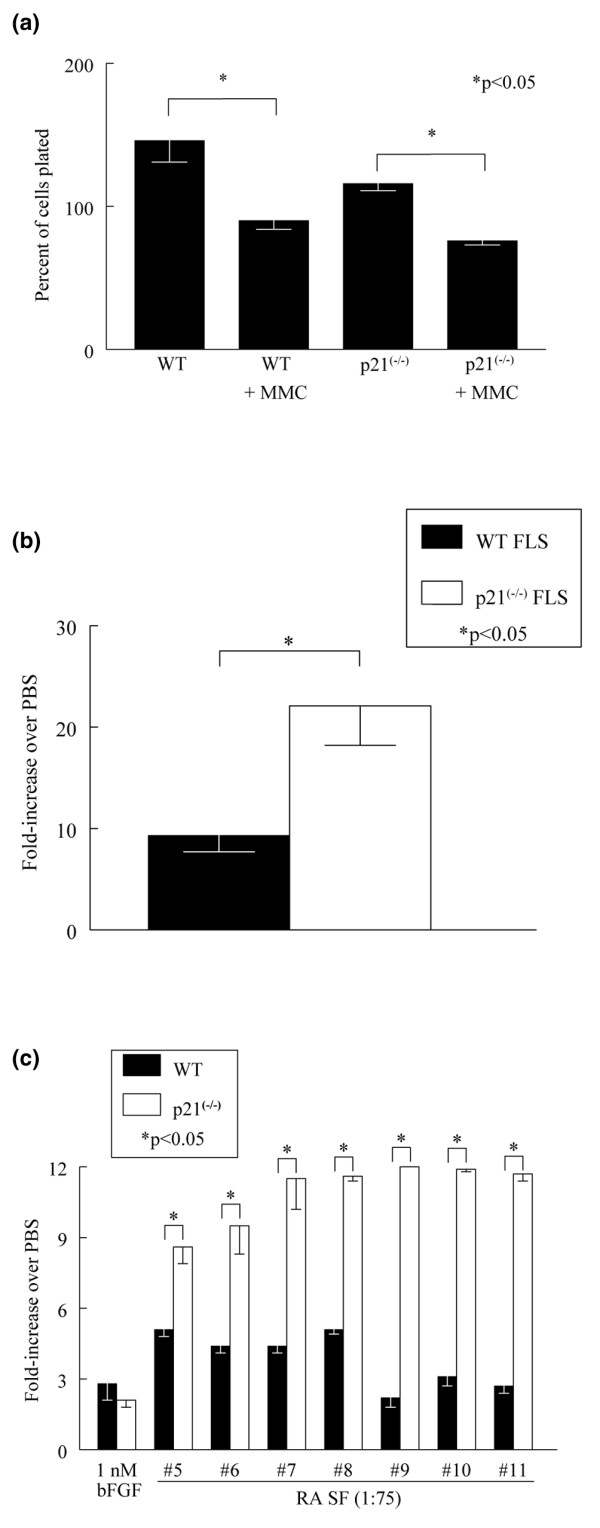
Enhanced migration of p21(-/-) fibroblast-like synoviocytes (FLS) to rheumatoid arthritis (RA) synovial fluid (SF) is independent of cell cycle regulation. (a) Wild-type (WT) and p21(-/-) FLS were treated identically to the chemotaxis assay in the presence and absence of mitomycin C (MMC) to determine whether the MMC conditions applied allowed for any proliferation of FLS. Cell counts are expressed as the percentage of cells plated, which was determined by counting the number of cells present after 2 h. The asterisk indicates a statistically significant difference between the groups, as determined from three identical experiments. (b) WT and p21(-/-) FLS were allowed to adhere to the bottom side of the membrane with the chamber inverted in the presence of 10 μg/ml MMC. Subsequently, cells were introduced to gradients of RA SFs diluted 1:75 to induce migration. Cell counts are expressed as fold-increase over background migration to PBS (negative control). An asterisk indicates a statistically significant difference. Combined chemotaxis data analyzed from seven separate patients in nine independent experiments demonstrates significantly more migration by the p21(-/-) FLS compared with WT FLS (p < 0.05). (c) A representative chemotaxis assay of 9 independent assays examining RA SF (1:75 dilution) from 7 separate patients randomly designated #5 to #11. bFGF, basic fibroblast growth factor.